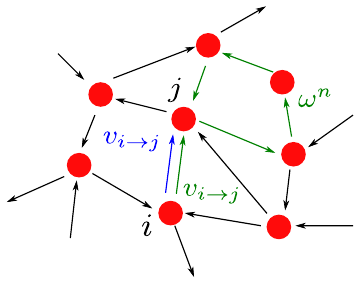
Figure 9. Two paths between quiver nodes i, j ∈ Q 0 . The blue path is the shortest path v i → j and the green path is the path decomposed into v